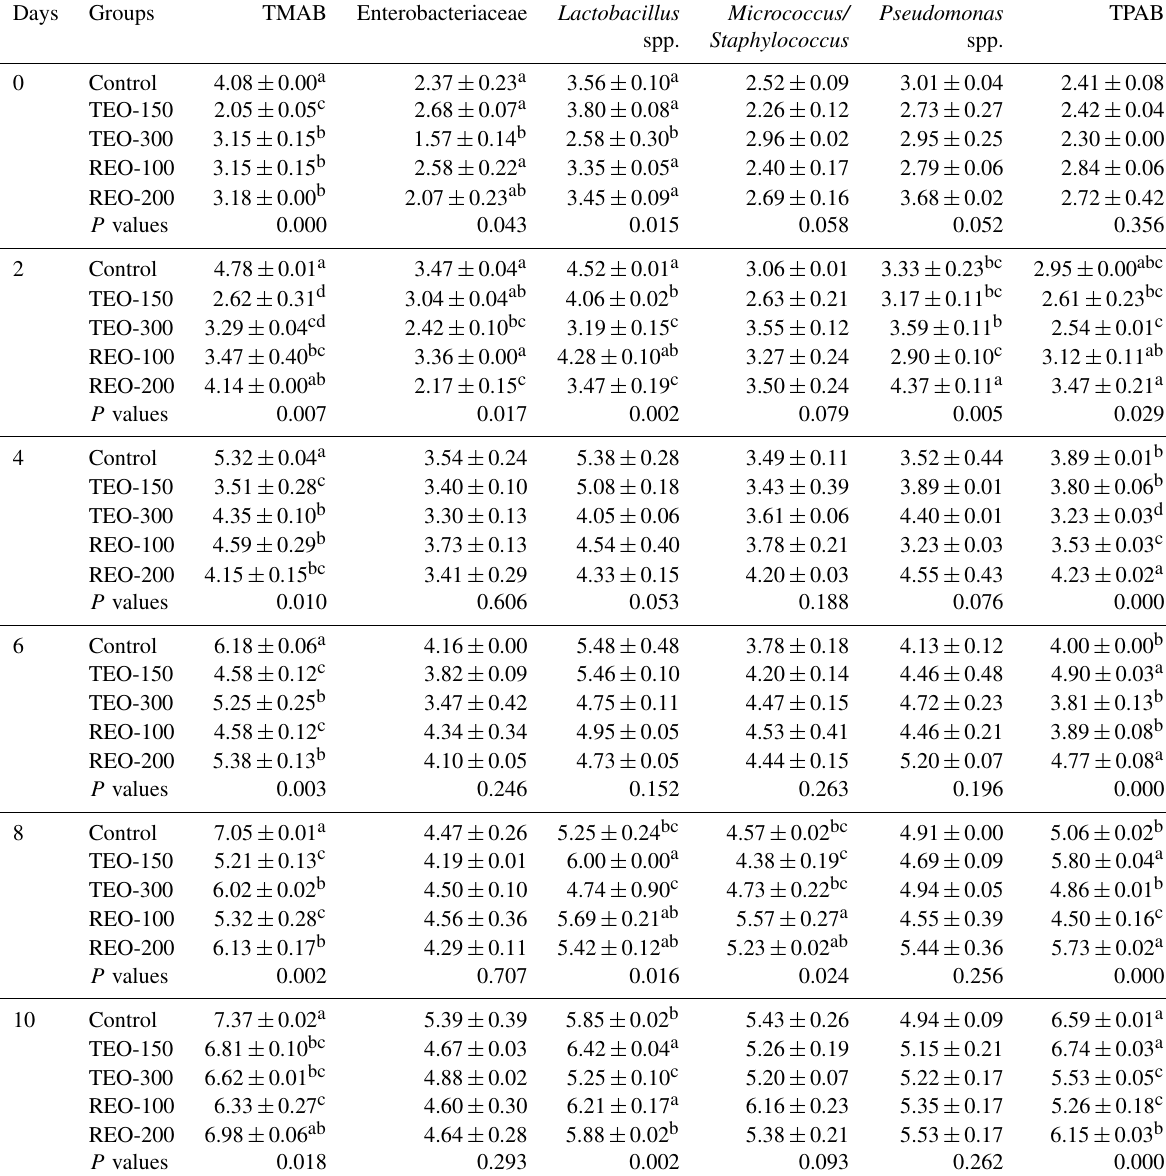
Table 4. Effects of dietary thyme and rosemary essential oils supplementation and storage time on TMAB, Enterobacteriaceae, Lactobacillus spp., Micrococcus/Staphylococcus spp., Pseudomonas spp. and TPAB counts in chicken drumstick meat (logcfug − 1